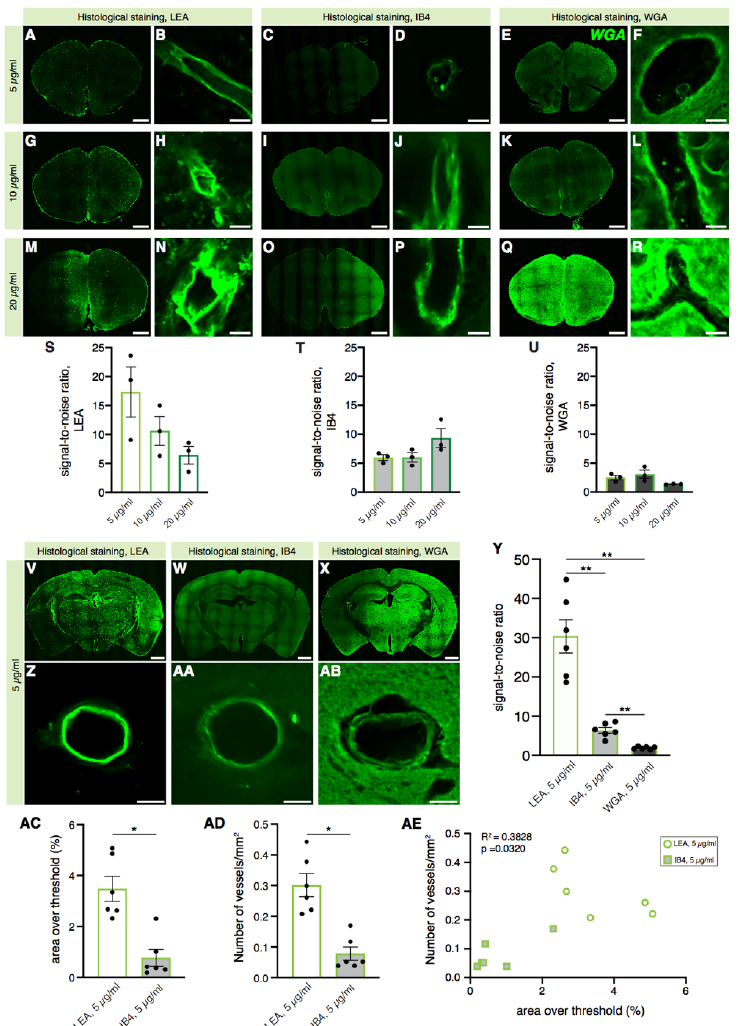
Figure 1. Labeling of blood vessels in free-floating brain sections by lectins Lycopersicon esculentum agglutinin (LEA), Griffonia simplicifolia isolectin B4 (IB4), and wheat germ agglutinin (WGA). ( A – R ) Representative confocal images of mouse brain sections histologically stained with the LEA, IB4, and WGA lectins at different concentrations. ( S – U ) Quantification of the signal-to-noise ratio. Each datapoint represents a single vessel; n = 1. ( V – AB ) Representative confocal images of (i) 10× mouse brain sections histologically stained with the LEA, IB4, and WGA lectin solutions at a concentration of 5 µg/mL ( V , W , X ) and (ii) high magnification (20×) of the blood vessels ( Z , AA , AB ) used for the quantification of the signal-to-noise ratio in ( Y ). Three vessels analyzed per animal, n = 6 mice (repeated measures one-way ANOVA, p = 0.0010; Tukey’s multiple comparisons test: WGA vs. IB4, p = 0.0039; WGA vs. LEA, p = 0.0025; IB4 vs. LEA, p = 0.0034). ** = p < 0.01. ( AC – AD ) Quantification of the area over the threshold (%) ( AC ) and of the number of vessels/mm 2 ( AD ) labeled by the IB4 and LEA lectins in brain sections. Each datapoint represents the averaged values in one single animal; n = 6 mice. (AC: Wilcoxon test, p = 0.0312; AD: Wilcoxon test, p = 0.0312). * = p < 0.05. ( AE ) Graph showing the existing correlation between the percentage of the area over the threshold and the number of vessels/mm 2 labeled with the IB4 and LEA lectins in brain sections. Each datapoint represents the averaged values in one single animal; n = 6 mice (correlation, Pearson coefficient: R 2 = 0.3828, p = 0.0320). Scale bars: 1000 µ m for low-magnification images, 10 µ m for high- magnification